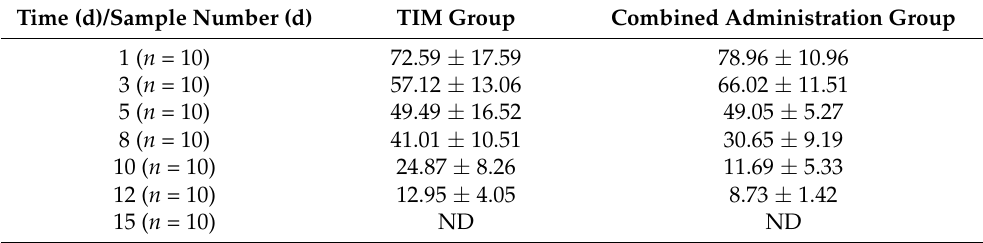
Table 10. Residual concentrations of TIM in eggs (mean ± SD, n = 10) ( µ g/kg).